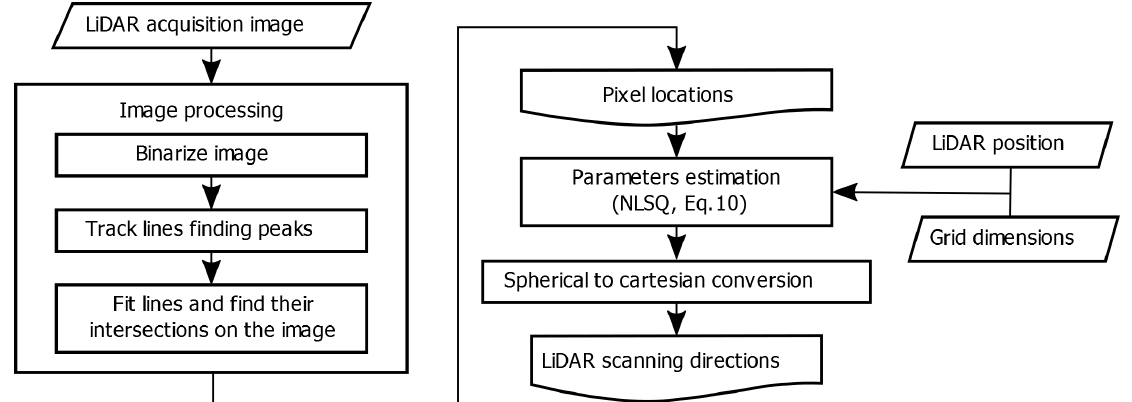
Figure 5. Step-by-step algorithm scheme for the estimation of the mapping